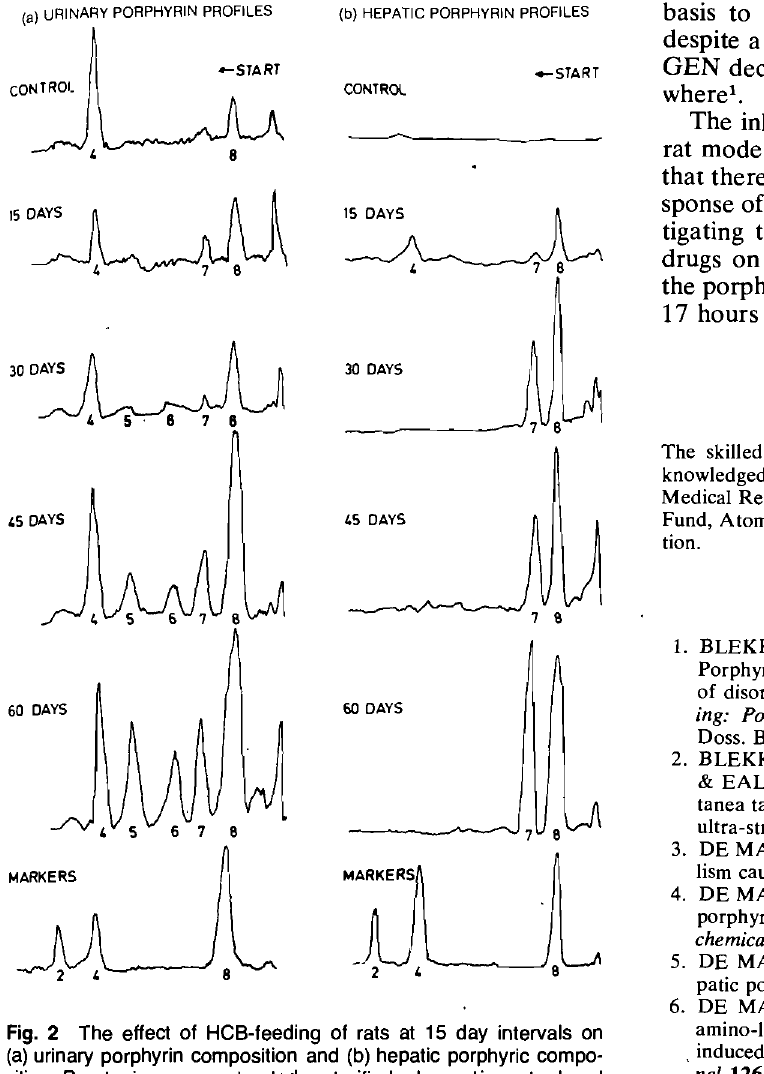
Fig. 2 The effect of HCB-feeding of rats at 15 day intervals on (a) urinary porphyrin composition and (b) hepatic porphyric compo sition. Porphyrins were extracted, esterified, chromatographed and the fluorometric scans using a Vitatron TLD 100 densitometer are~ shown. Numerals below each peak refer to the number of carboxyl groups of the